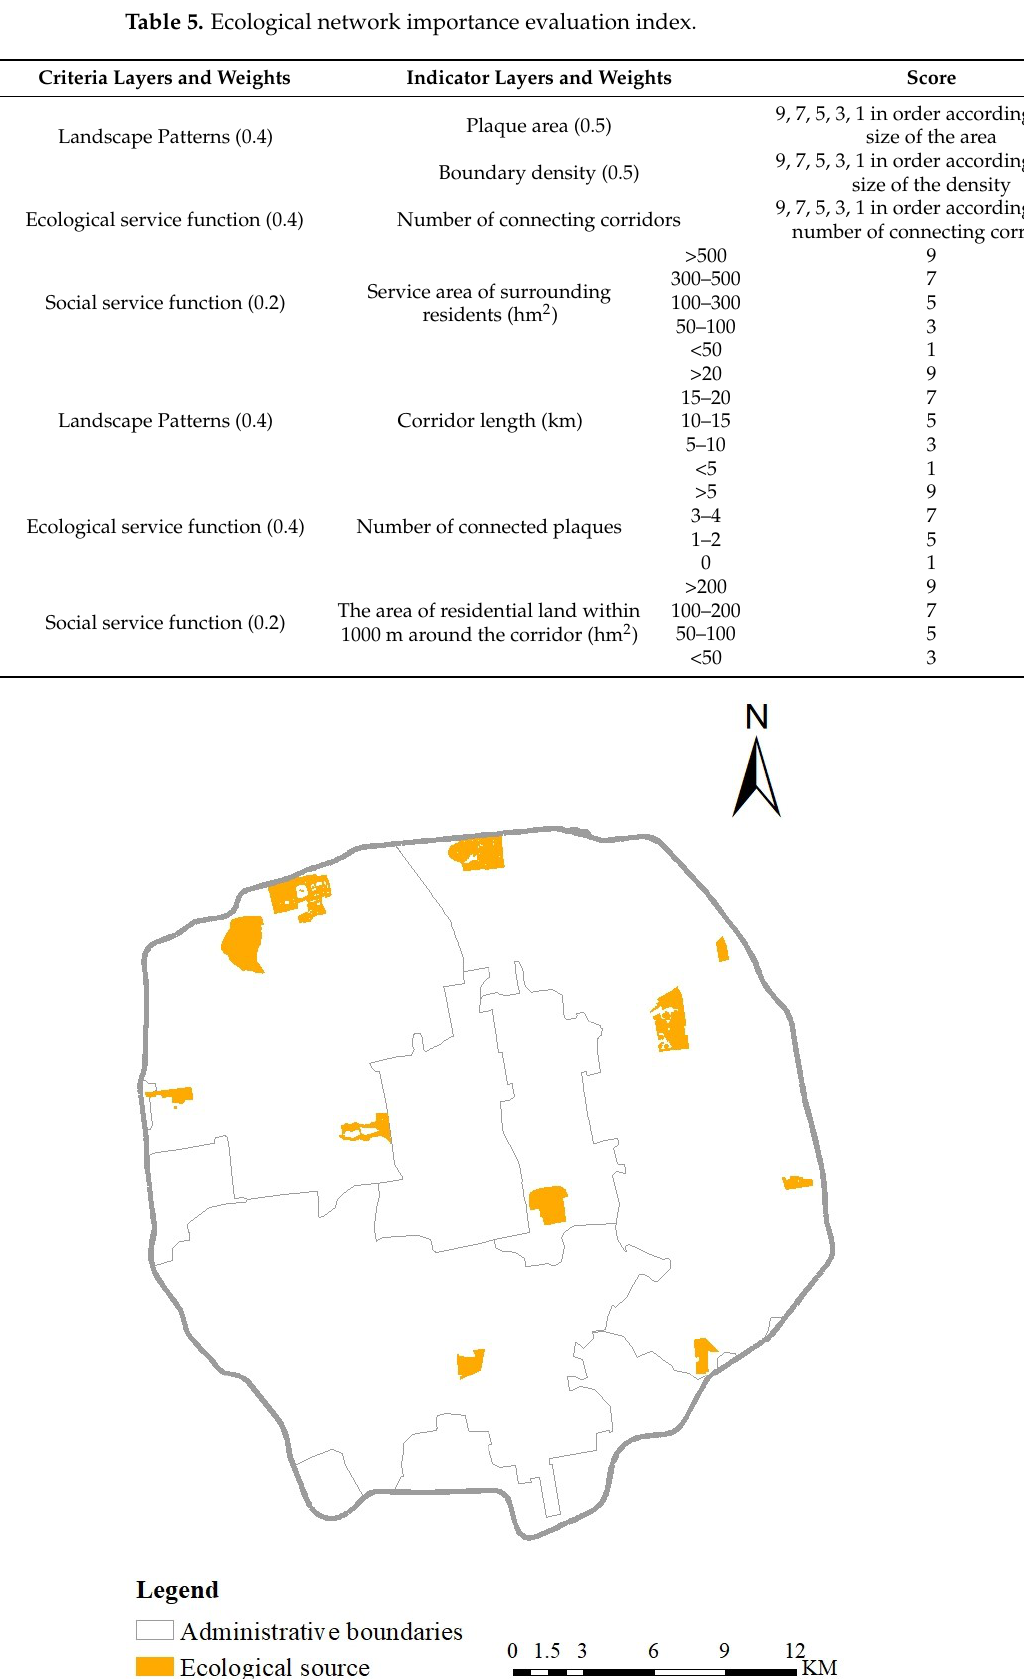
Figure 4. Ecological source.